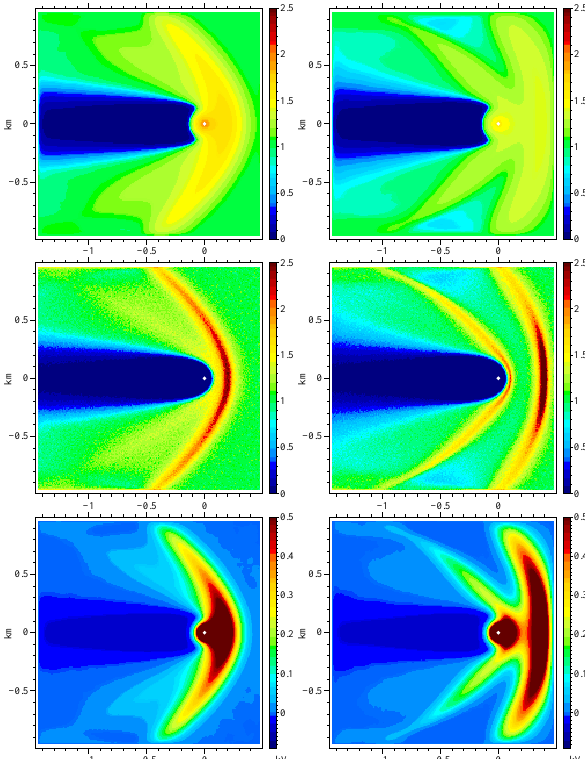
Figure 2. Physically realistic run (left, ν = 0 . 12) and non-physical run (right, ν = 0 . 08) which exhibits double ion deflection shock. The panels are electron density (top), ion density (middle) and elec- tric potential (bottom). Densities are relative to n o . White dot shows tether position at the origin.